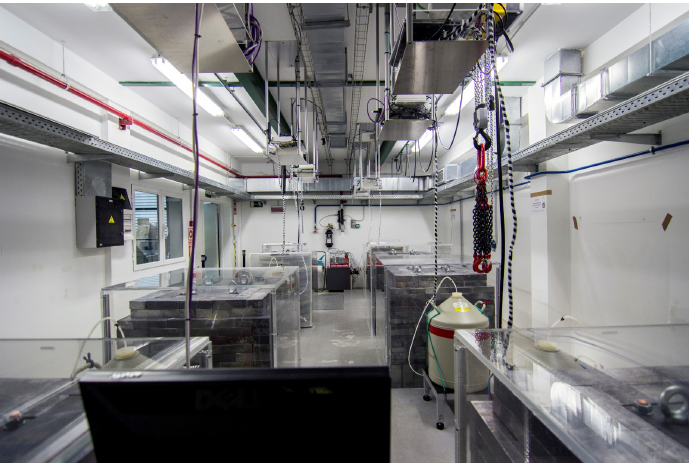
Figure 19. ULBS laboratory in Hall C of LSC.